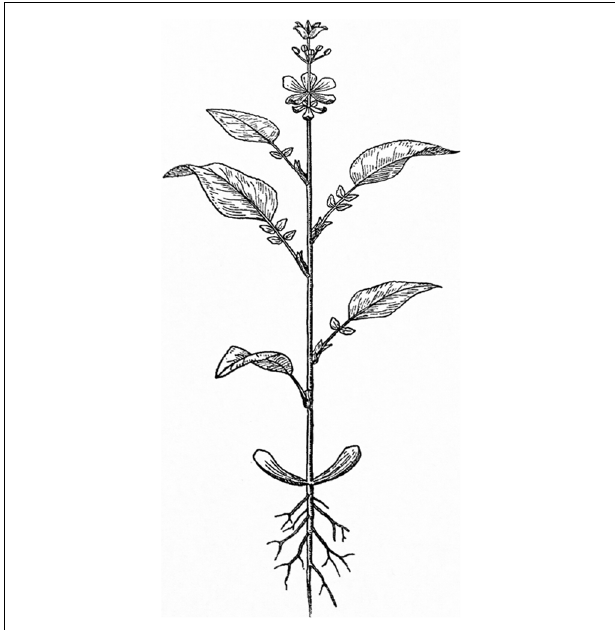
FIGURE 1 |The annual plant as viewed by Goethe (represented by Troll).